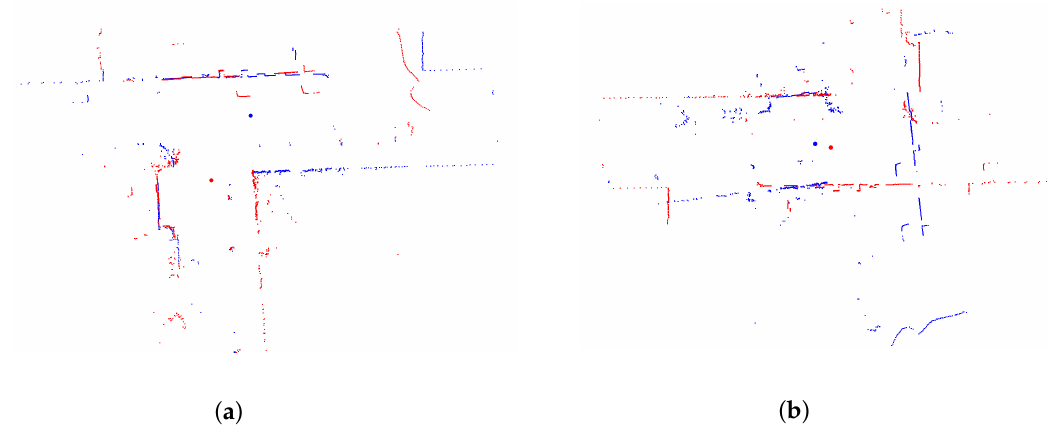
Figure 7. An example of false loop closure detected by DIMC. The blue points belong to the target scan and the red points belong to the source scan. The translation error between ( a ) and ( b ) is 2.624 meters. ( a ) Direct matching result. ( b ) Inverse matching